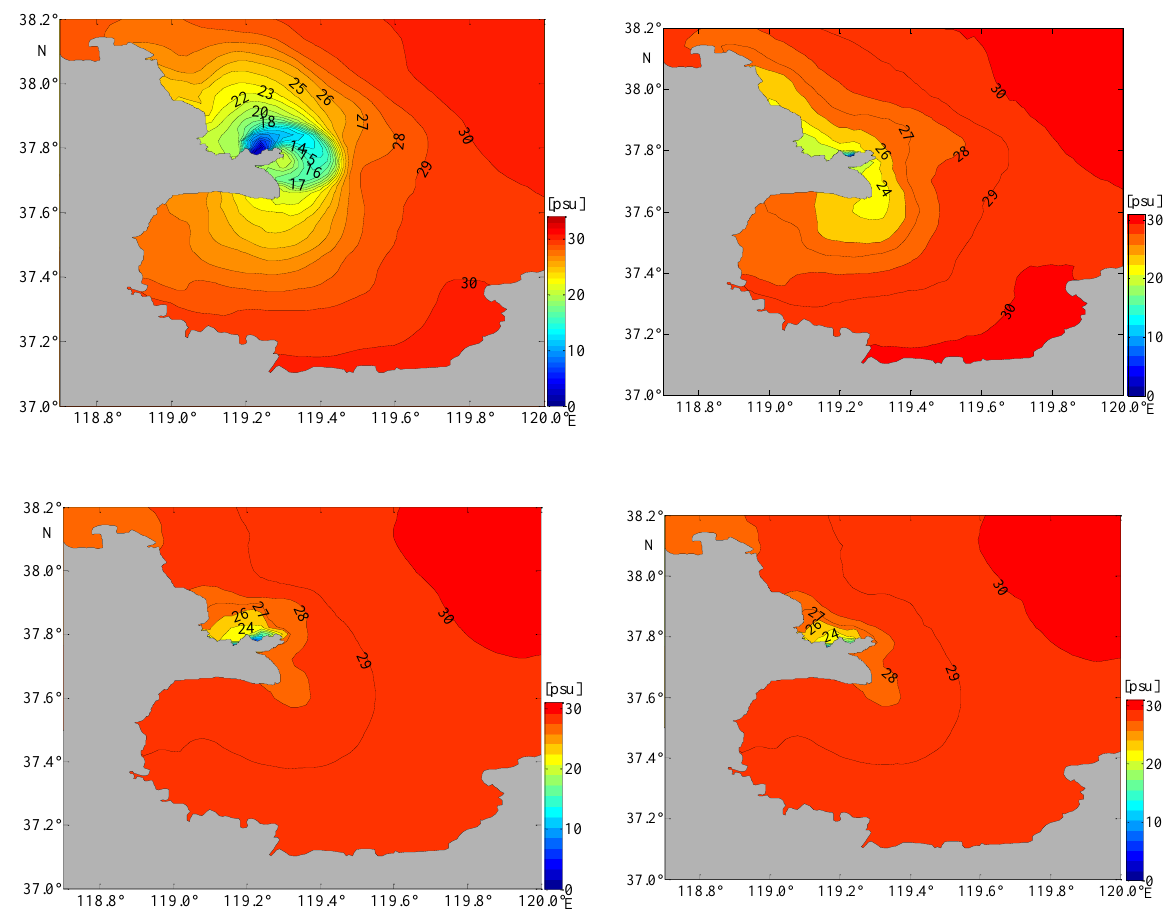
Figure 10. Distribution of surface ( right ) and bottom ( left ) salinity in the wet ( top ) and dry ( bottom ) seasons.